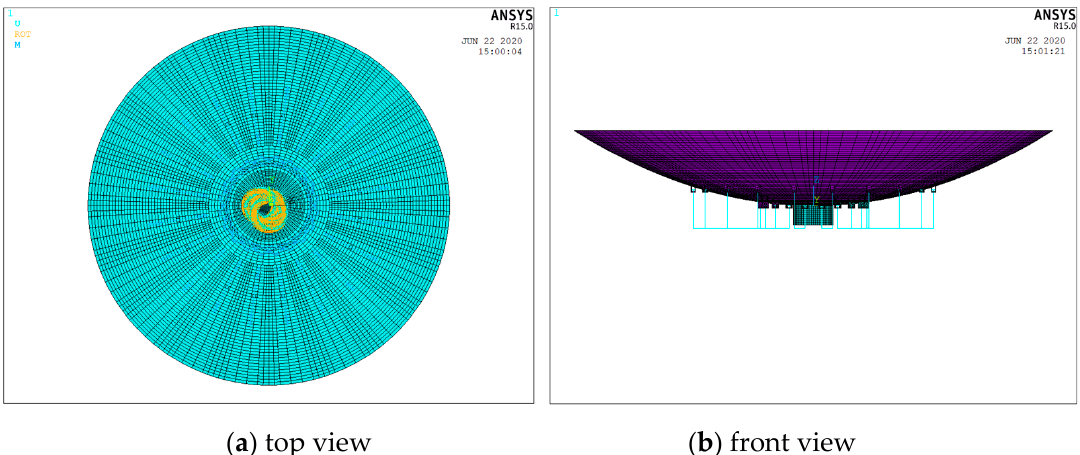
Table 1. Material parameters.